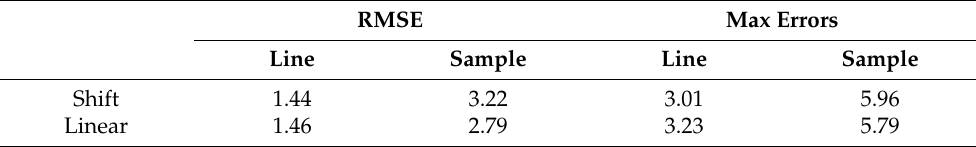
Table 4. Accuracy of mosaic strip RPCs after the bias compensation (unit: pixels).